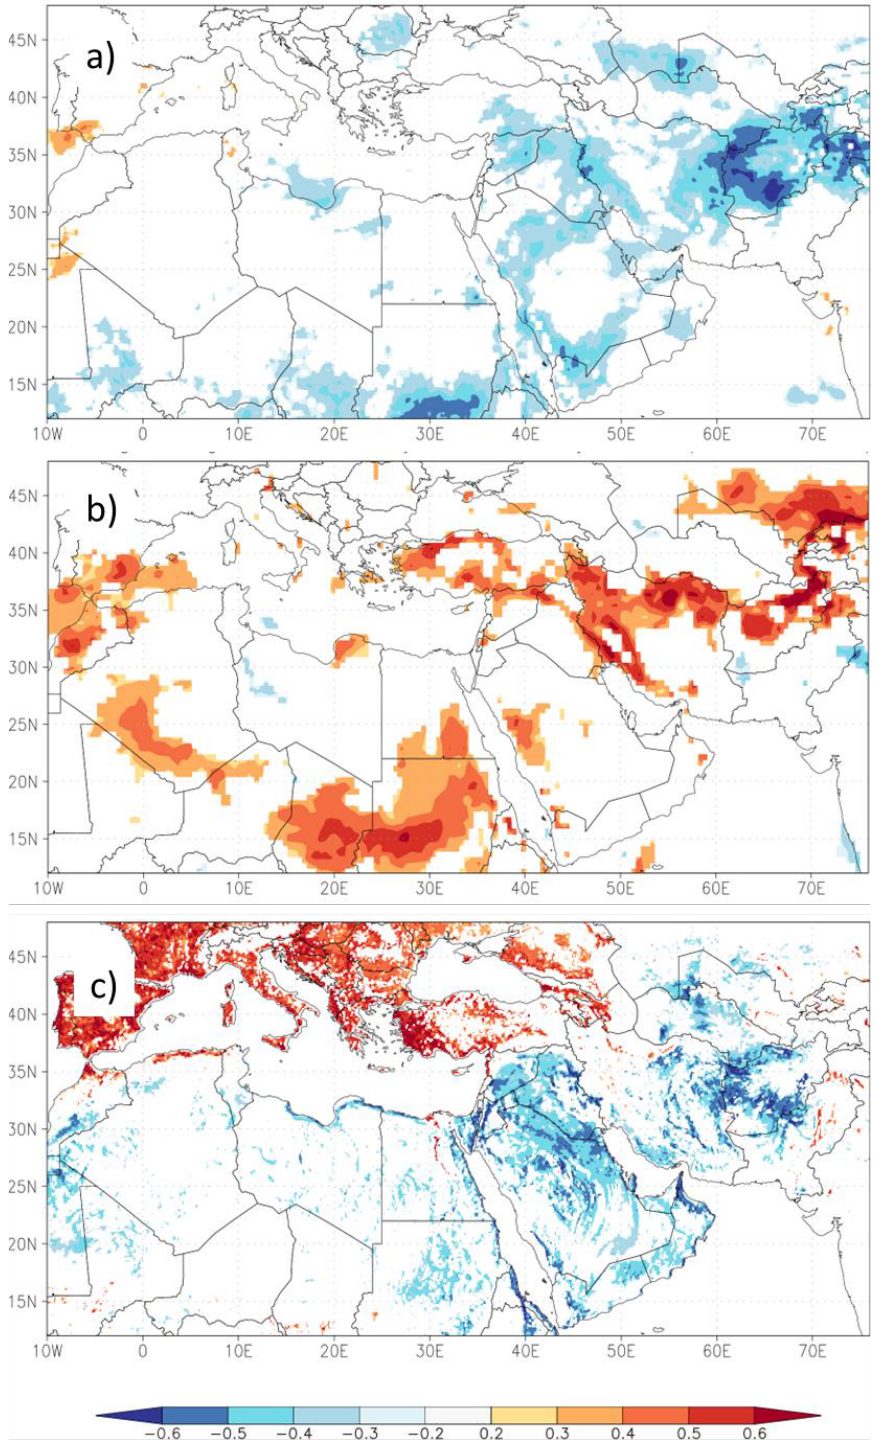
Figure 11. Same as Figure 10, but for the CAE subregion during the dust season of March to August.